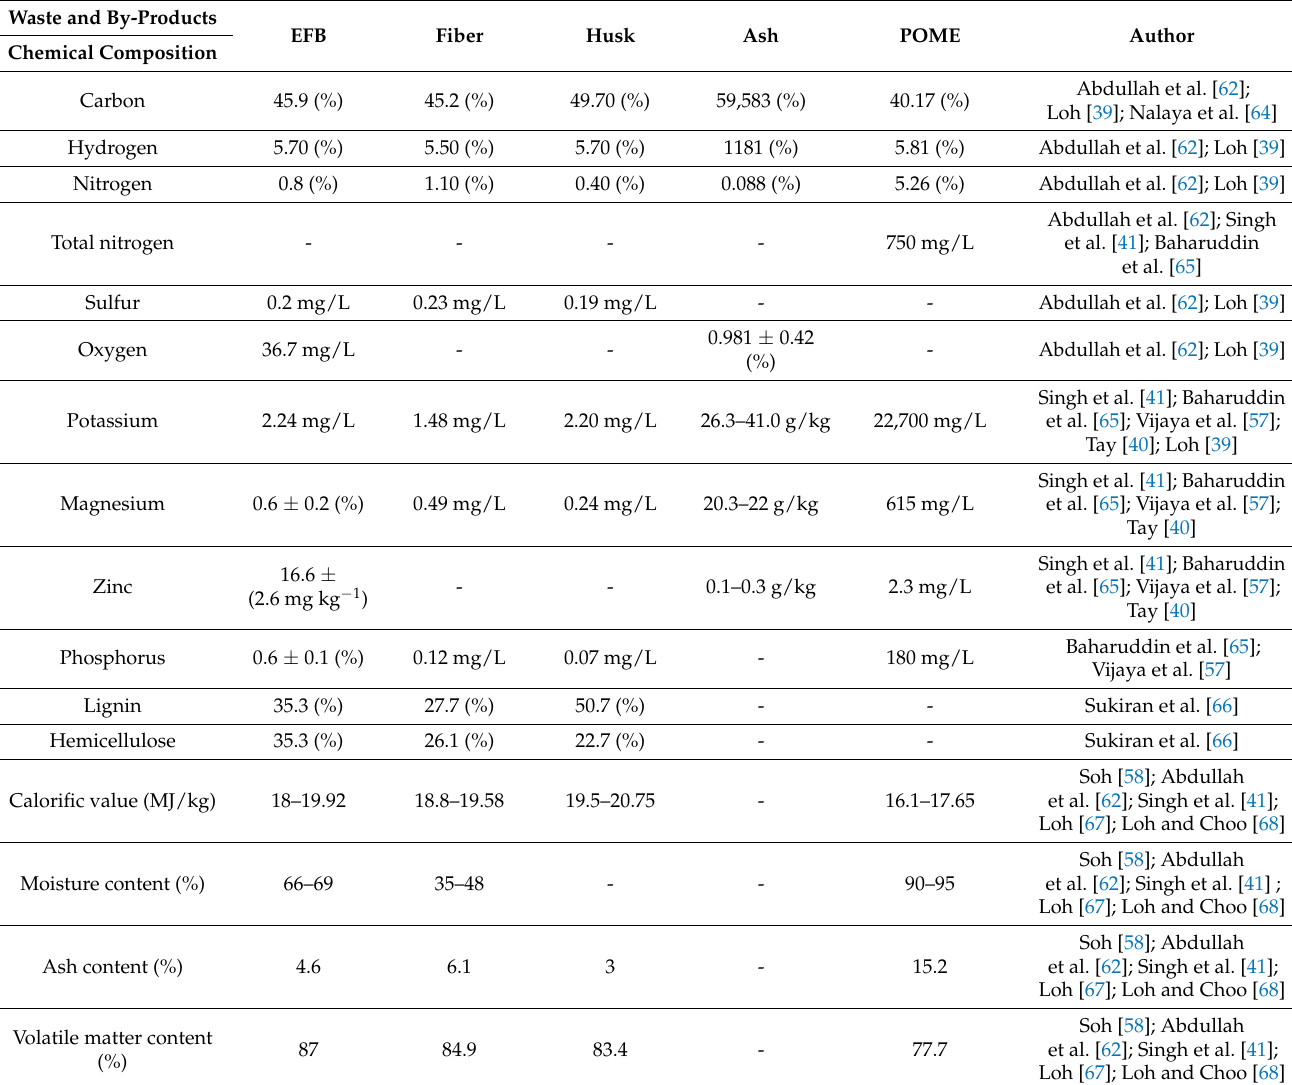
Table 6. Chemical and physical composition of the waste and by-products generated in the transfor- mation phase of the